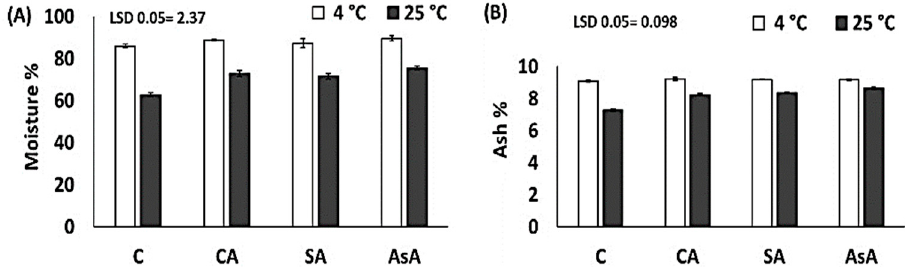
Figure 7. Effects of bio-stimulants B, control (C), citric acid (CA), salicylic acid (SA) and ascorbic acid